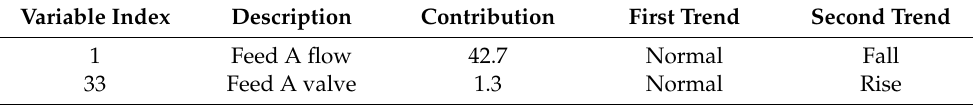
Table 7. The contributions of abnormal variables in 2 min after disturbance introduction.